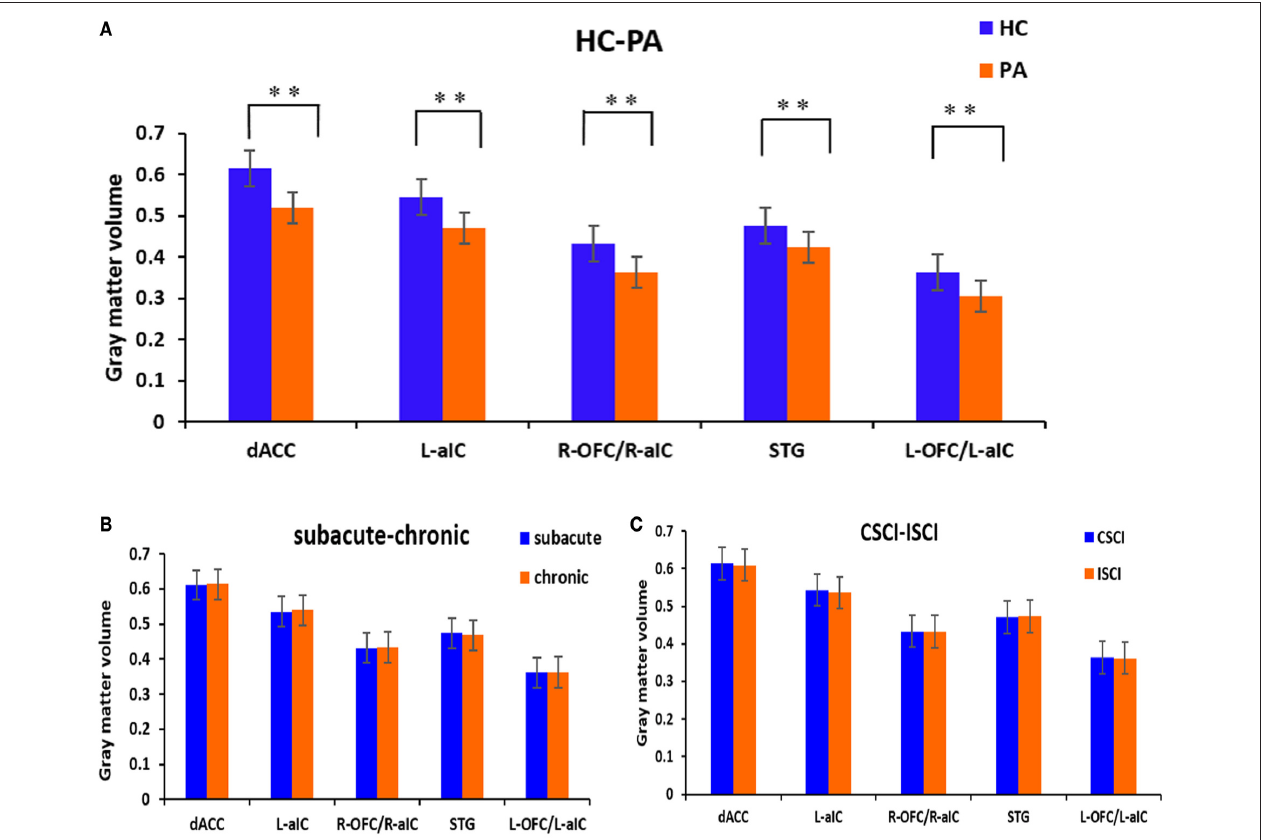
FIGURE 2 | GM volumetric changes between different sub-groups based on region of interest (ROI) analysis. (A) Differences between the patients with SCI and healthy controls; (B) differences between the sub-acute and chronic sub-groups; (C) differences between the CSCI and ISCI sub-groups. ROIs were extracted based on the VBM findings. **Statistical significance with cluster wise FWE-corrected p ≤ 0.05. dACC, dorsal anterior cingulate cortex; L-aIC, left anterior insular cortex; R-aIC, right anterior insular cortex; L-OFC, left orbital frontal cortex; R-OFC, right orbital frontal cortex; STG, right superior temporal